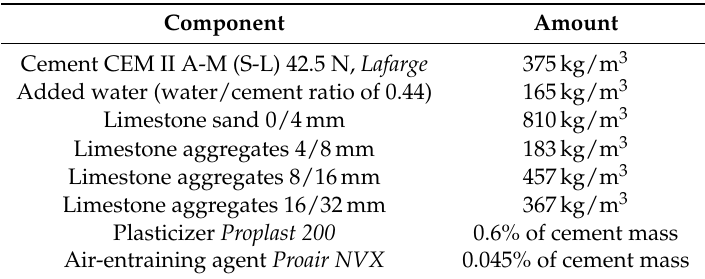
Table 1. Composition of the concrete mixture (concrete grade